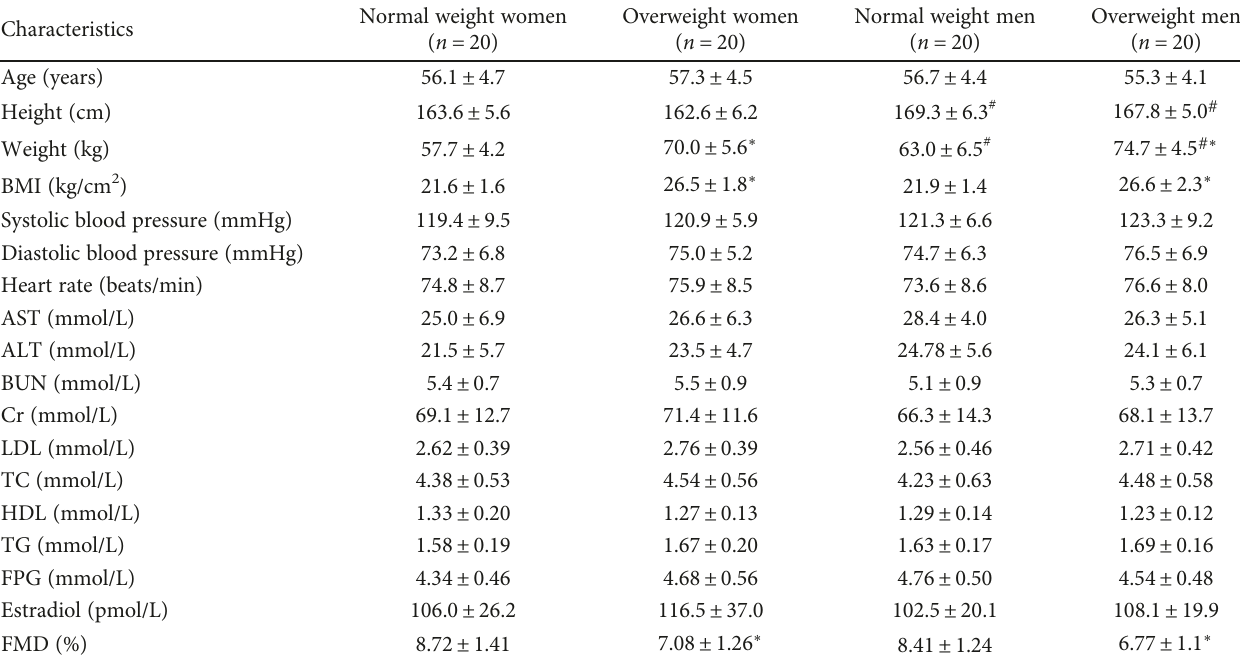
Table 1: Clinical and biochemical